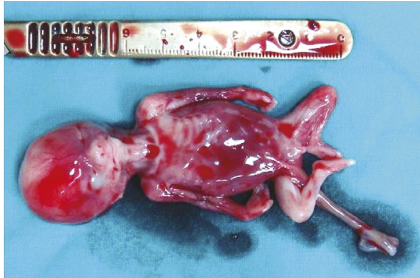
Figure 2: Photograph of the dead